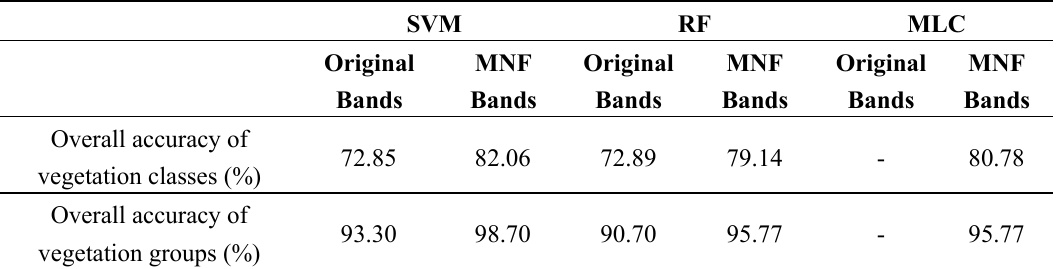
Table 5. Classification accuracy of the vegetation classes and vegetation groups with respect to three classifiers using both original and nine MNF-transformed bands for 30 random training pixels. SVM RF MLC Original MNF Original MNF Original MNF Bands Bands Bands Bands Bands Bands Overall accuracy of 72.85 82.06 72.89 79.14 - 80.78 vegetation classes (%) Overall accuracy of 93.30 98.70 90.70 95.77 - vegetation groups (%)